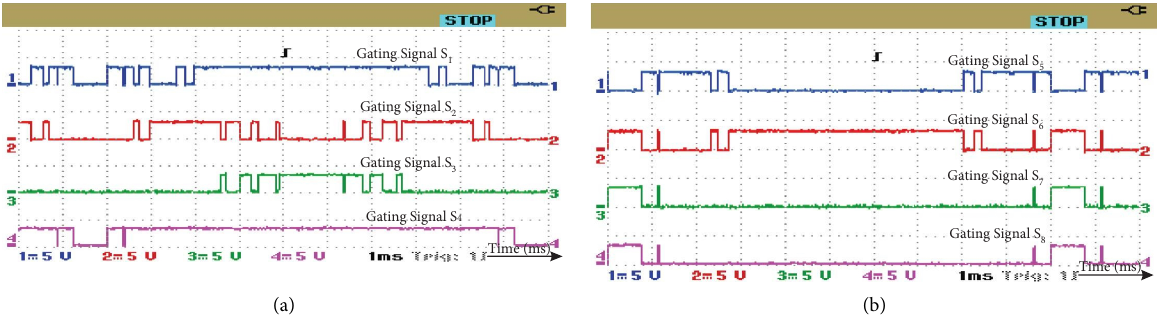
Figure 19: Gating pulses for proposed nine-level inverter switches (a) S